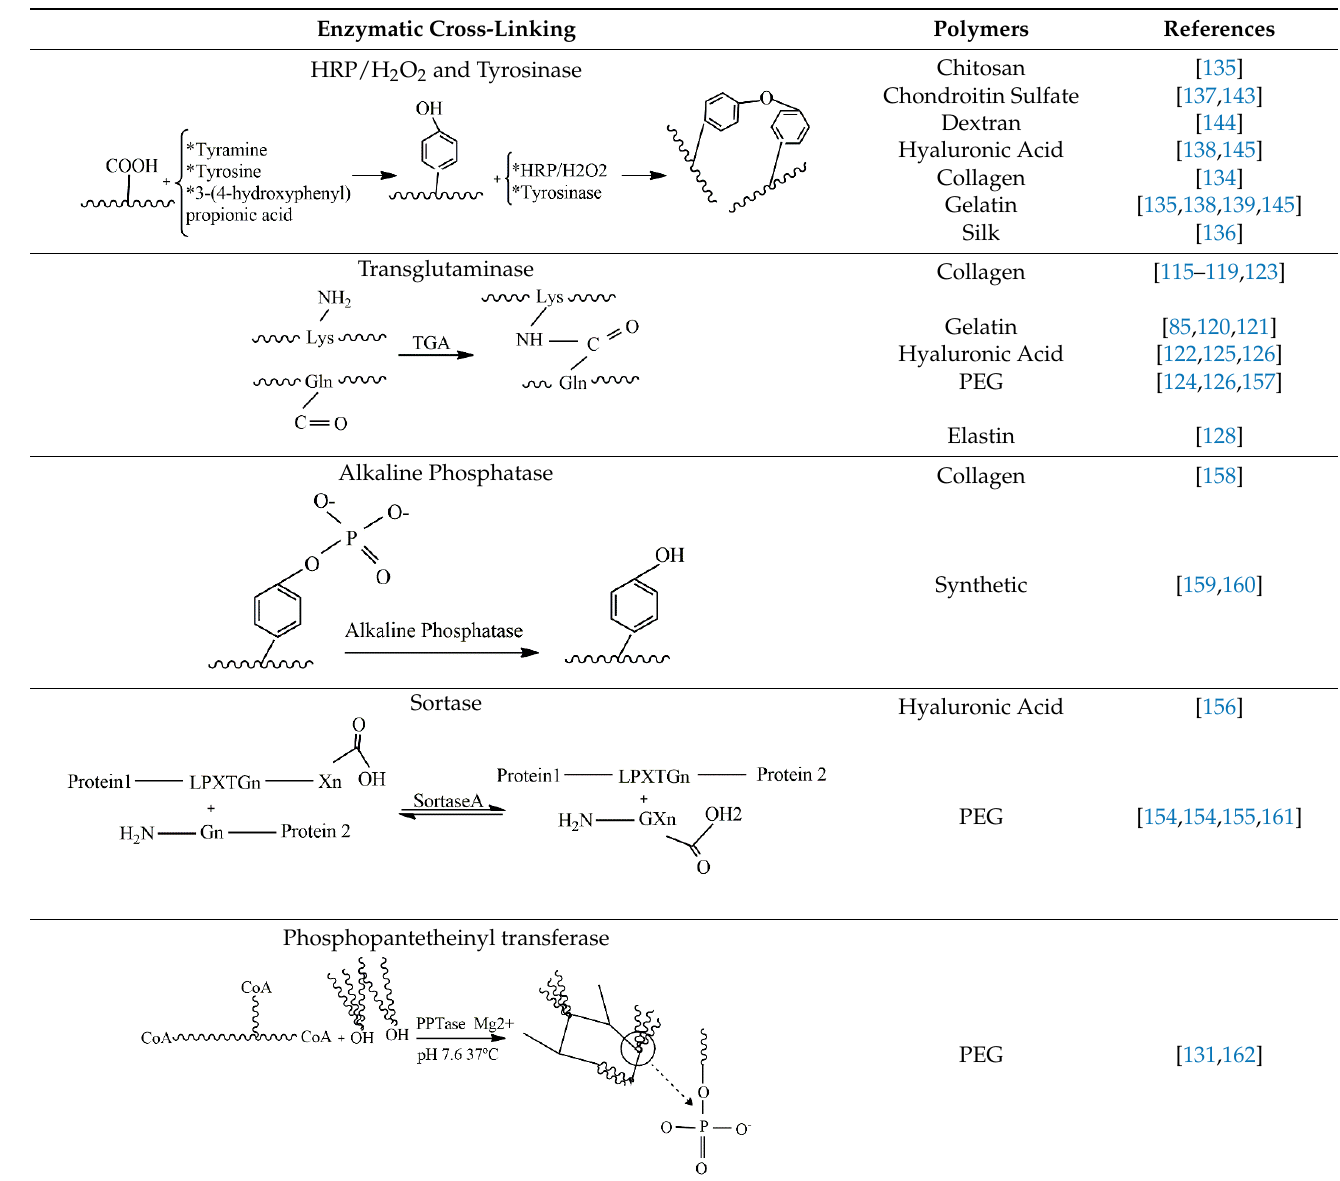
Table 2. Summary of the most common enzymatic cross-linking mechanisms for bioinks and inject- able hydrogels.